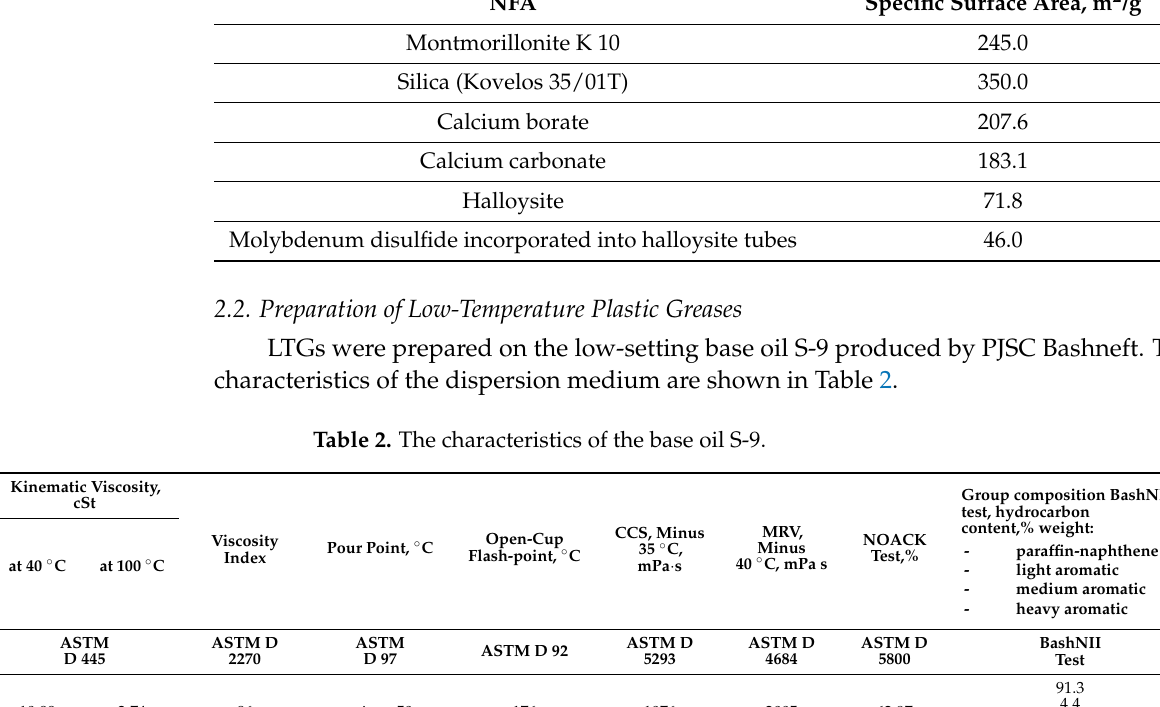
Table 2. The characteristics of the base oil S-9.